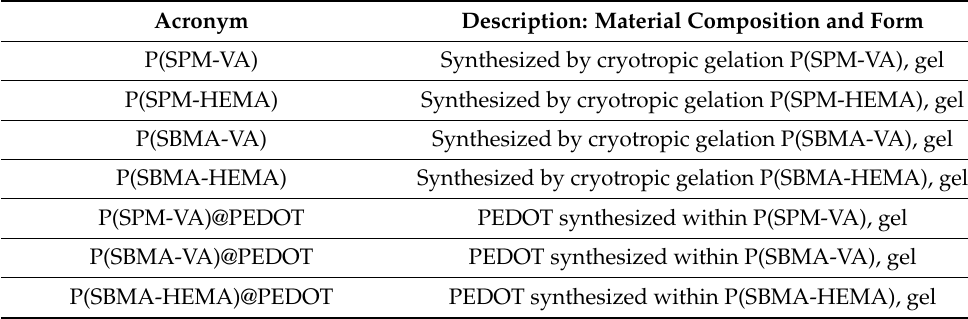
Table 1. Sample acronyms and description.